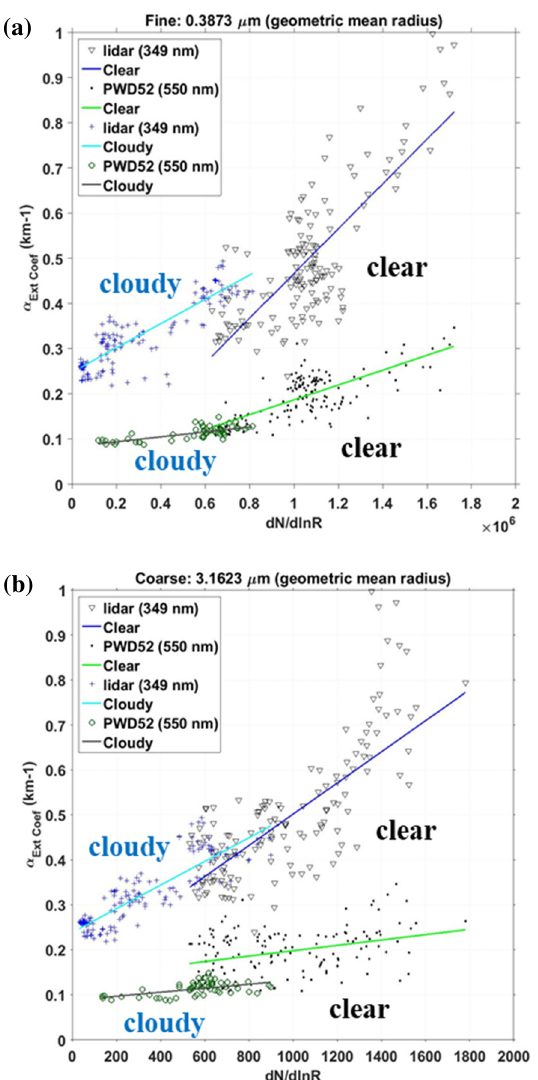
Fig. 3. Extinction coefficient at 349 nm (lidar) and 550 nm (PWD52) versus the number concentration (OPC) for (a) fine and (b) coarse